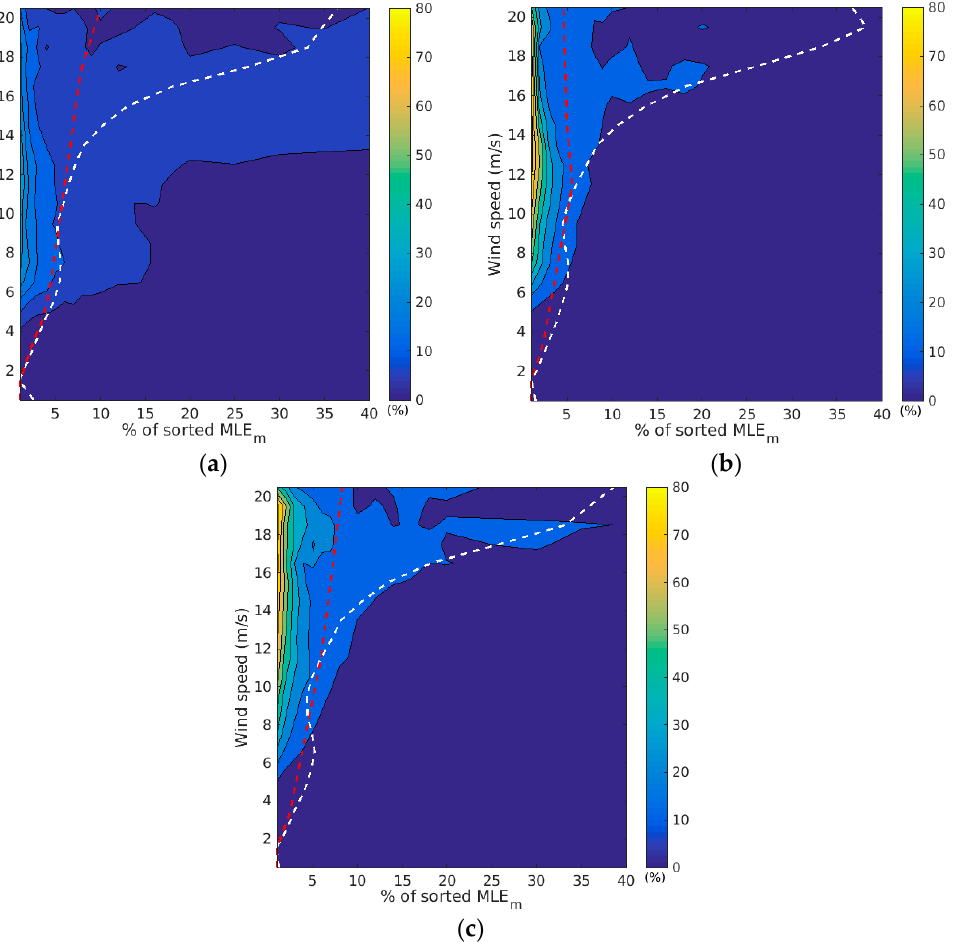
Figure 5. Percentage of rain-contaminated data (GMI RR > 1 mm/h) as a function HSCAT-B wind speed and the sorted percentiles by MLE m : ( a ) outer swath; ( b ) sweet swath; ( c ) inner swath. Red-dashed curves depict the proposed QC rejection ratio as a function of wind speed, whereas white-dashed curves indicate the operational rejection